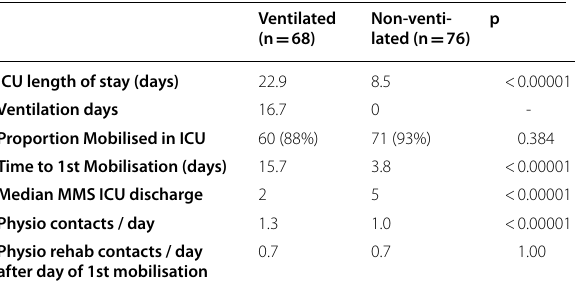
Table 1—– comparison of outcomes for ventilated and non ventilated